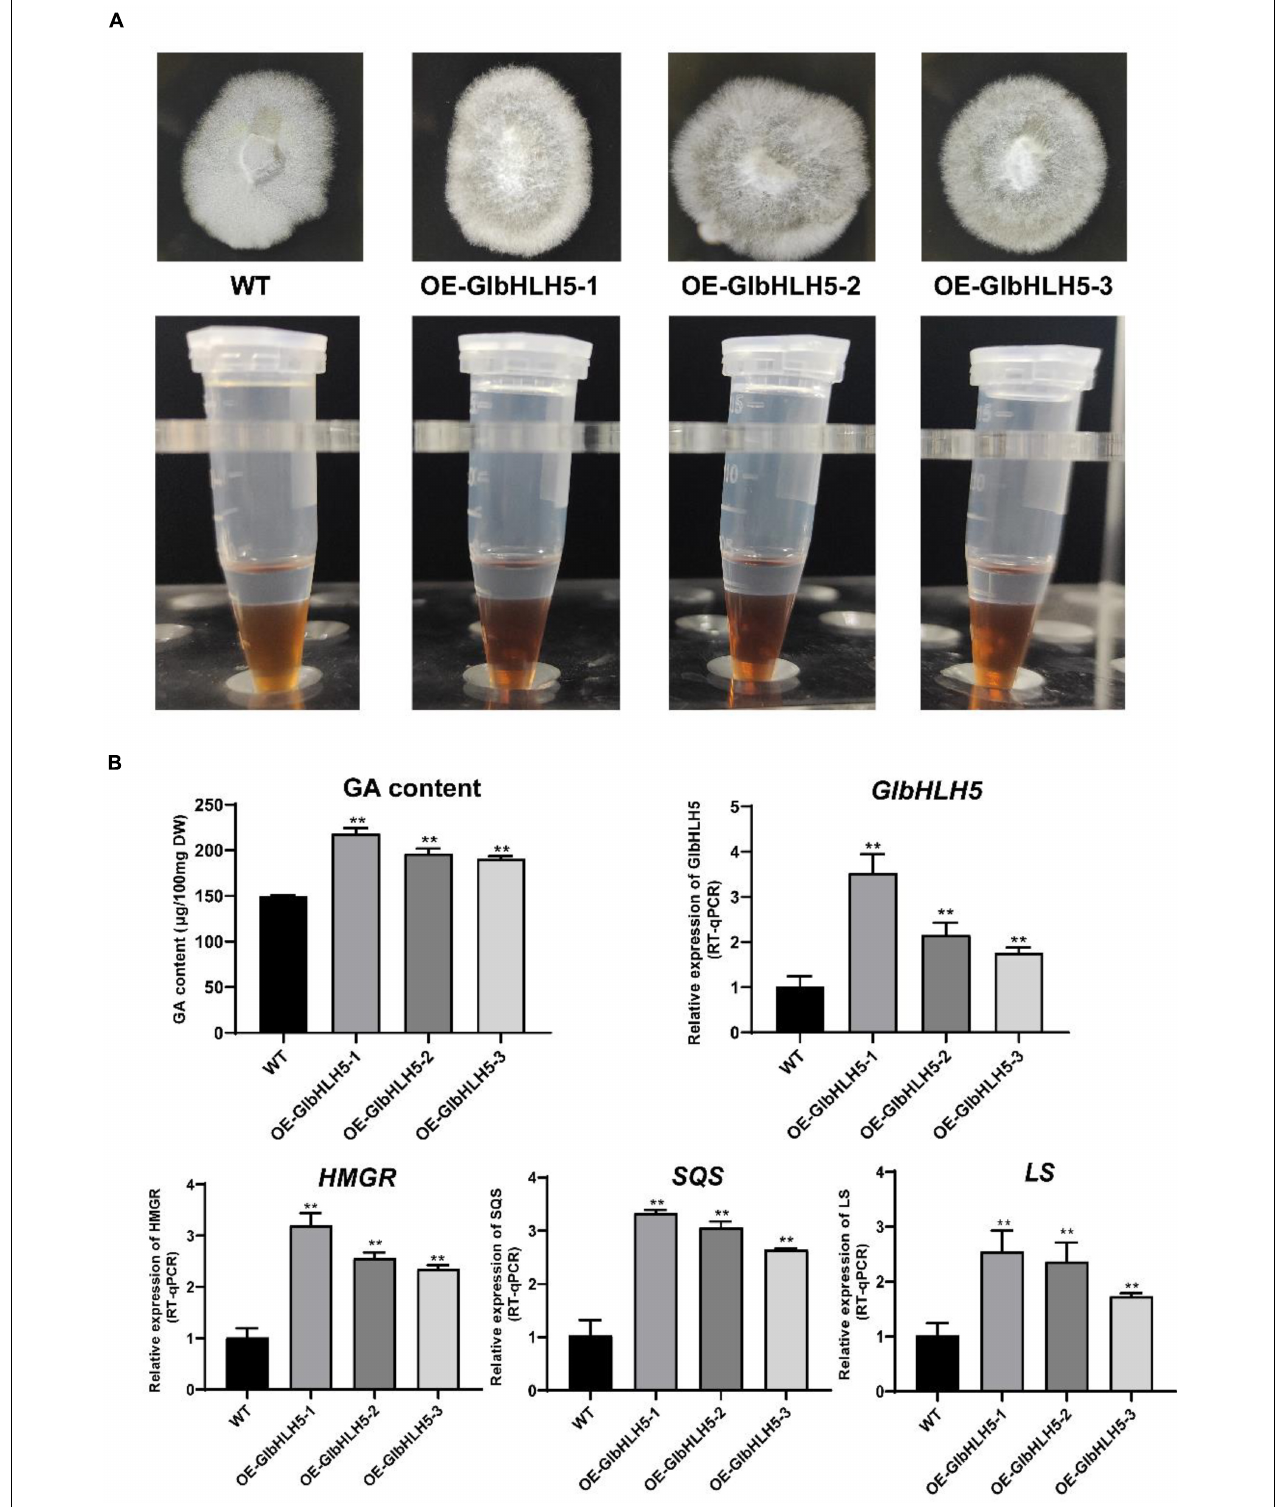
FIGURE 6 | Phenotypic and relative gene expressions analysis of the GlbHLH5 overexpression strains. (A) The phenotypes of the three GlbHLH5 overexpression and the control lines of Ganoderma lucidum and the coloration differences between extracts of different lines. (B) The quantitative analysis of triterpenoids and the key genes transcriptions of the biosynthetic pathway in the GlbHLH5 overexpression and the control lines. “**” means the difference is extremely significant ( P < 0.01).